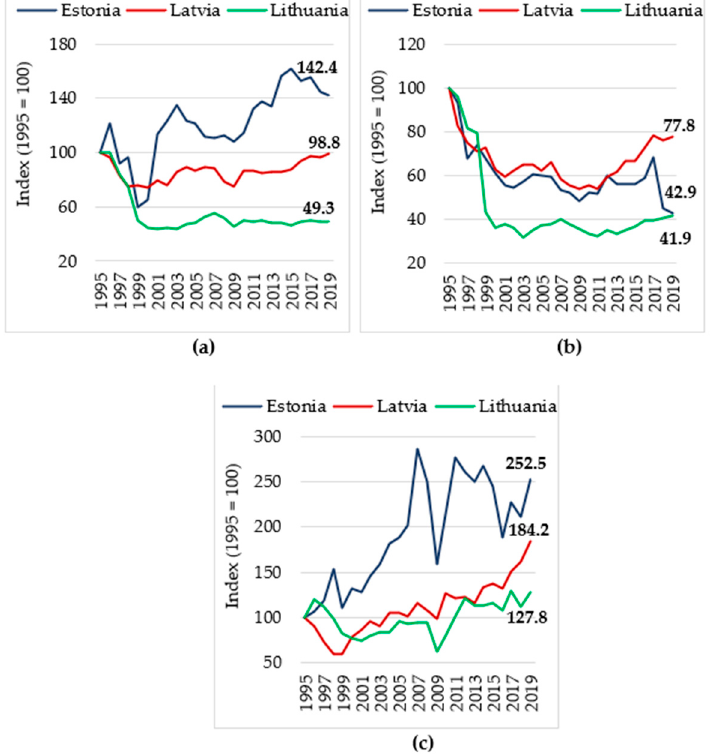
Figure 2. Baltic States time series: ( a ) total energy use in agriculture (NU); ( b ) electricity use in agriculture (LU); ( c ) Gross value added generated by agriculture (GV). Source: authors’ calculations based on Eurostat [68] and FAOSTAT [69] data, 2022. Table 1. Descriptive statistics of total energy use by agriculture (NU), electricity use by agriculture (LU), and gross value added generated by agriculture (GV).